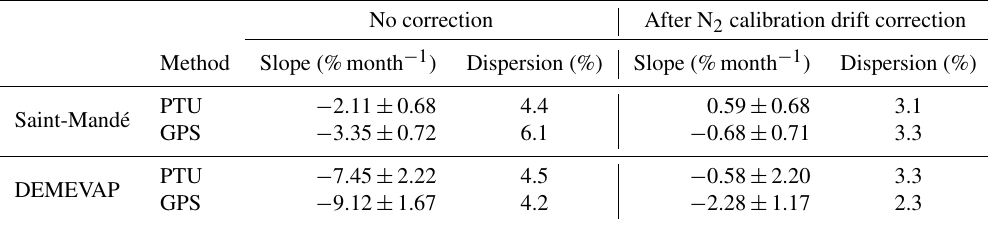
Table 3. Comparison of the stability of the PTU and GPS H 2 O calibration methods during the Saint-Mandé and DEMEVAP campaigns, before (left) and after (right) correction of a linear drift fitted from N 2 calibration